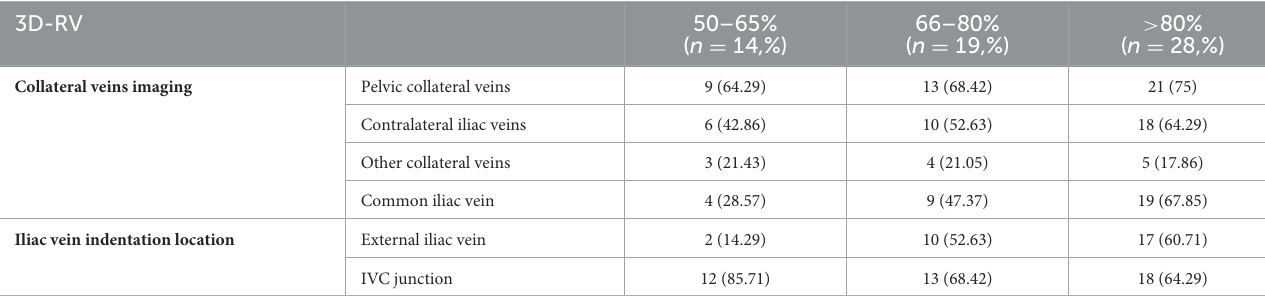
TABLE 2 The imaging effect of 3D-RV on iliac vein compression per subgroup.